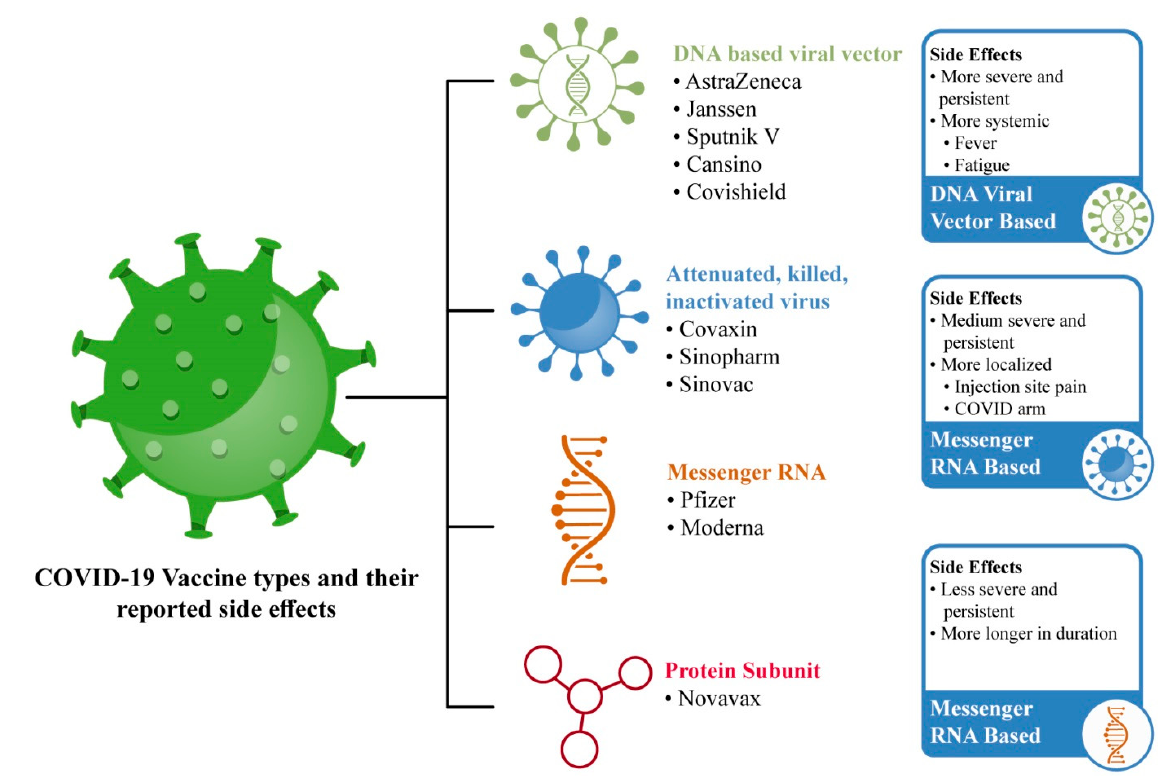
Figure 1. Most-utilized COVID-19 vaccinations and their frequently reported